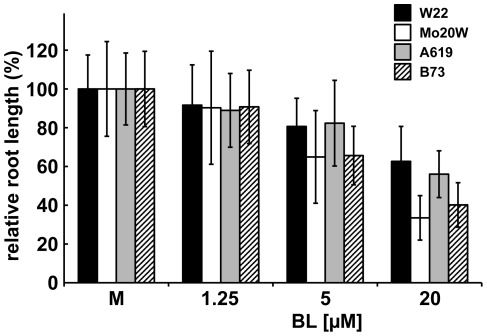
Influence of the genetic variation on the BR sensitivity in maize root.Maize inbred seedlings W22, Mo20W, A619, and B73 grown in vermiculite for 8 d at 29°C in the dark in the presence or absences of 1.25, 5, or 20 µM BL, respectively. Average length of the primary root measured at the end of treatment (n>15). Error bars represent standard deviation. Statistical analysis determined by “Post-hoc” test (p<0.05) is shown in Table S3.